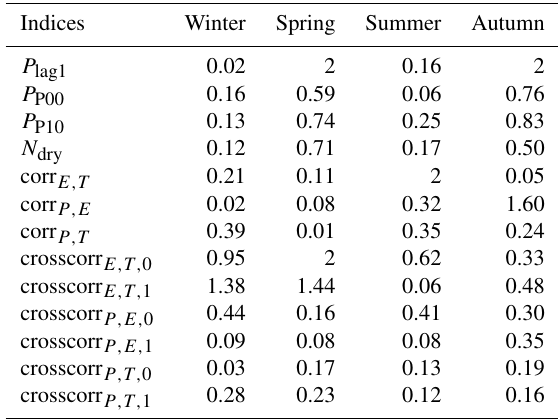
Table 4. R index values for occurrence and correlation for 1970– 1989 as historical period and 1998–2017 as future